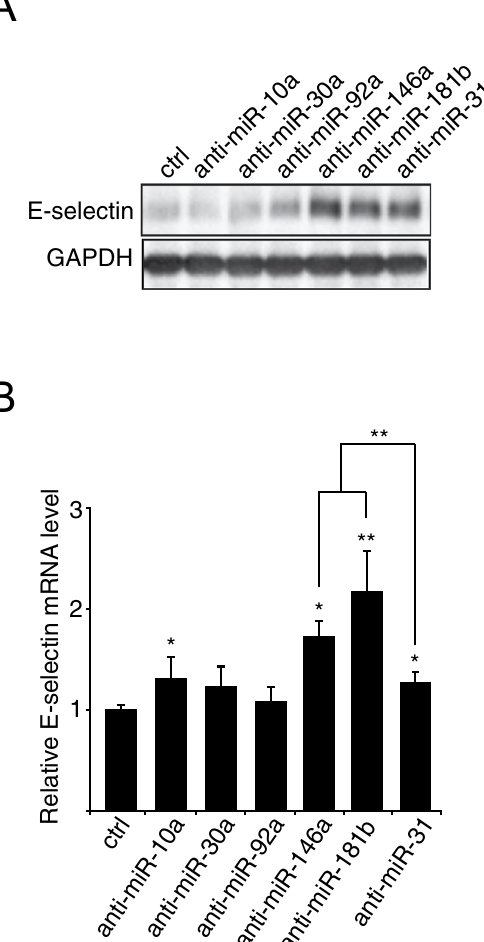
Figure 1. miR-146a and miR-181b repress the transcription of E-selectin. A. B. Human Umbilical Vein Endothelial Cells (HUVECs) cultivated as monolayers were transfected with 50 nM of miRNA inhibitors (anti-miR) or controls (ctrl), before being treated with IL-1 β (20ng/ml) for four hours. ( A ) The expression of E-selectin was monitored by Western blotting. GAPDH was used as loading control. ( B ) RT-qPCR monitored the level of E-selectin mRNA relative to GAPDH mRNA. The Western blot is representative of four independent experiments. The quantification are the mean values of four independent experiments, the error bars represent standard errors of four independent experiments, and the significance was analyzed using a Student’s t-test. The p -values are calculated comparing to the ctrl, unless indicated otherwise ( * p < 0.05; ** p <